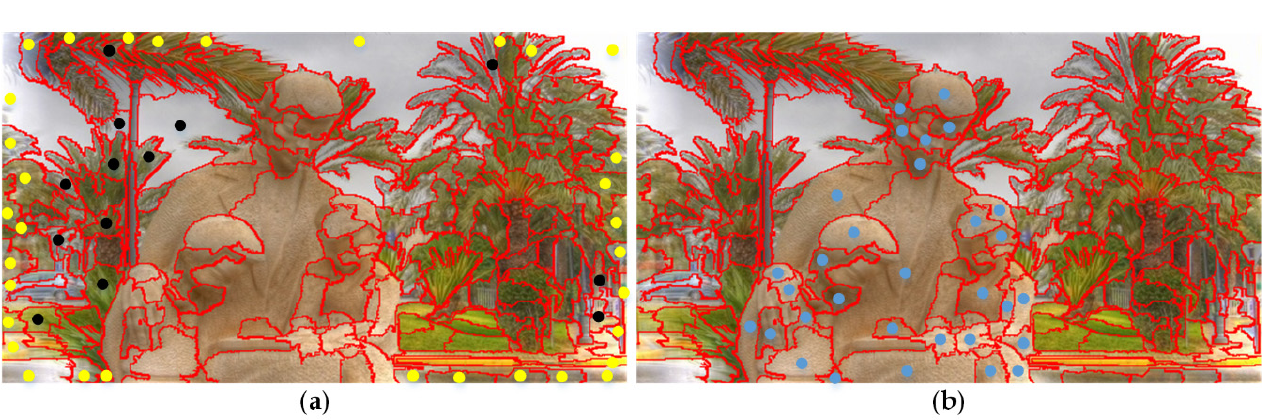
Figure 7. Relevant schematic diagrams of the bilateral absorbing Markov chain model. ( a ) The construction of background- based absorbing Markov chain model: mirror edge superpixels (yellow dots) and a few non-edge background superpixels (black dots) as virtual absorbing nodes; ( b ) The construction of foreground-based absorbing Markov chain model: mirror foreground superpixels (blue dots) as virtual absorbing nodes. Both set all superpixels on the entire image as transient nodes.